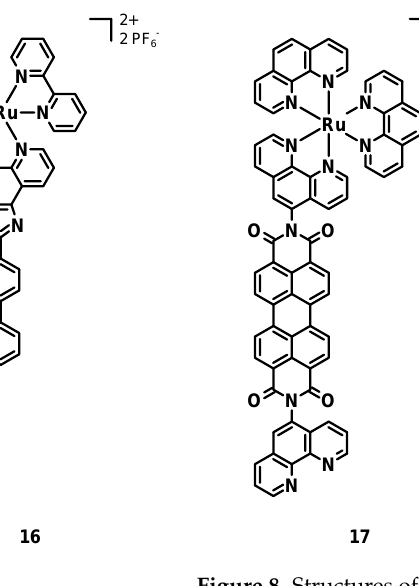
Figure 8. Structures of complexes 16 , 17 , 18 , and 19 .